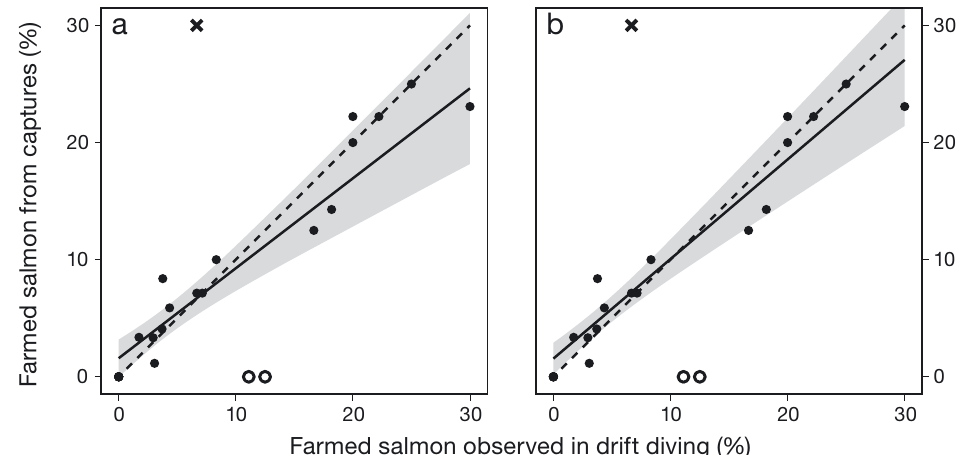
Fig. 5. (a) Bayesian inference comparing the proportion of escaped Atlantic salmon observed in drift diving and captured with nets; (b) the same relationship after removing 2 outliers (open circles). Solid line: fitted line; dashed line: 1:1 relationship; shaded area: 95% credibility intervals (CI). Fitted line and CIs were calculated from all points—solid and open circles in (a) (adj. r 2 = 0.79). Outliers removed due to limitations outside of individual identification; e.g. escape during net capture (b) (adj. r 2 = 0.93). The × in both panels indicates a point that was removed from the analysis due to an unrepresentative and biased net